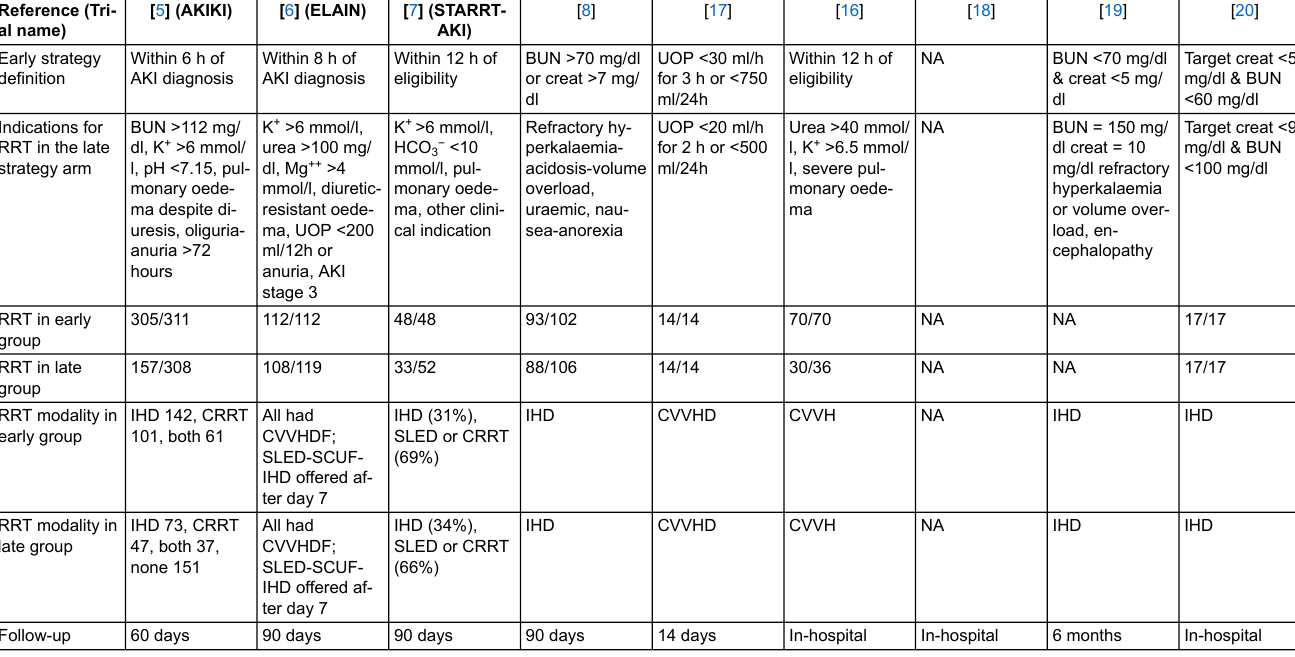
Table 2: Definition of early renal replacement therapy strategy, indications for dialysis in the late strategy arm, and renal replacement modality in each treatment group.